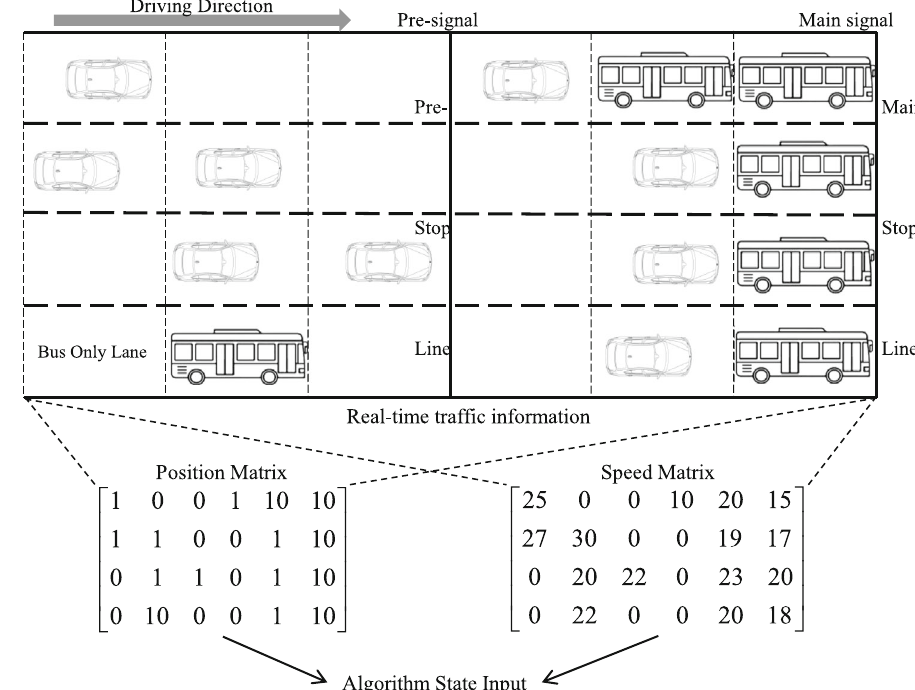
Fig. 3 DTSE schematic